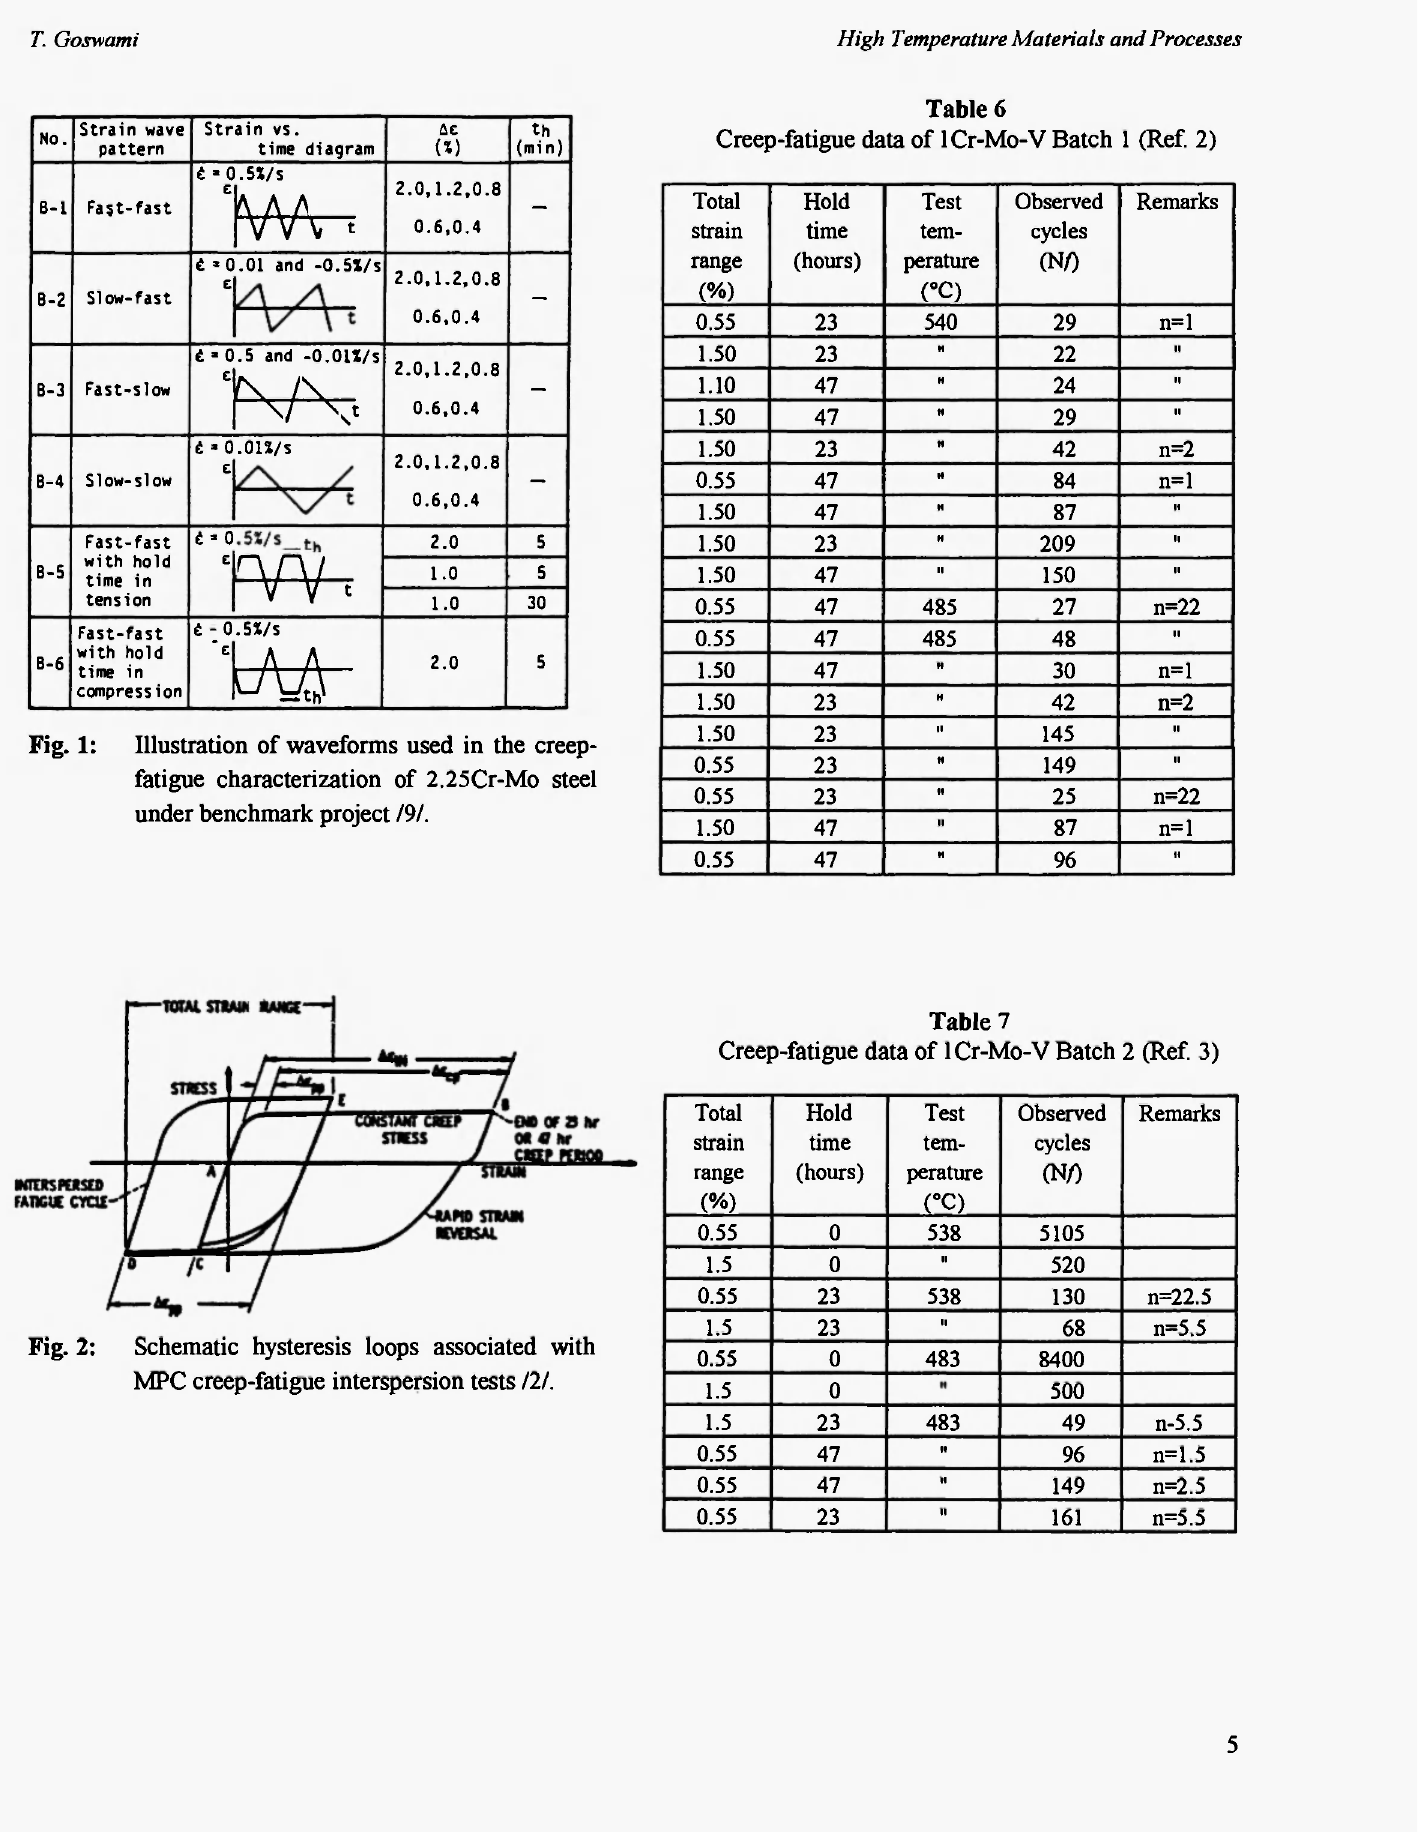
Fig. 2: Schematic hysteresis loops associated with MPC creep-fatigue interspersion tests 121.